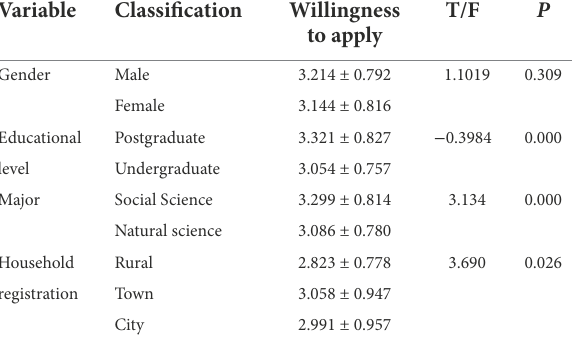
TABLE 6 Difference test.